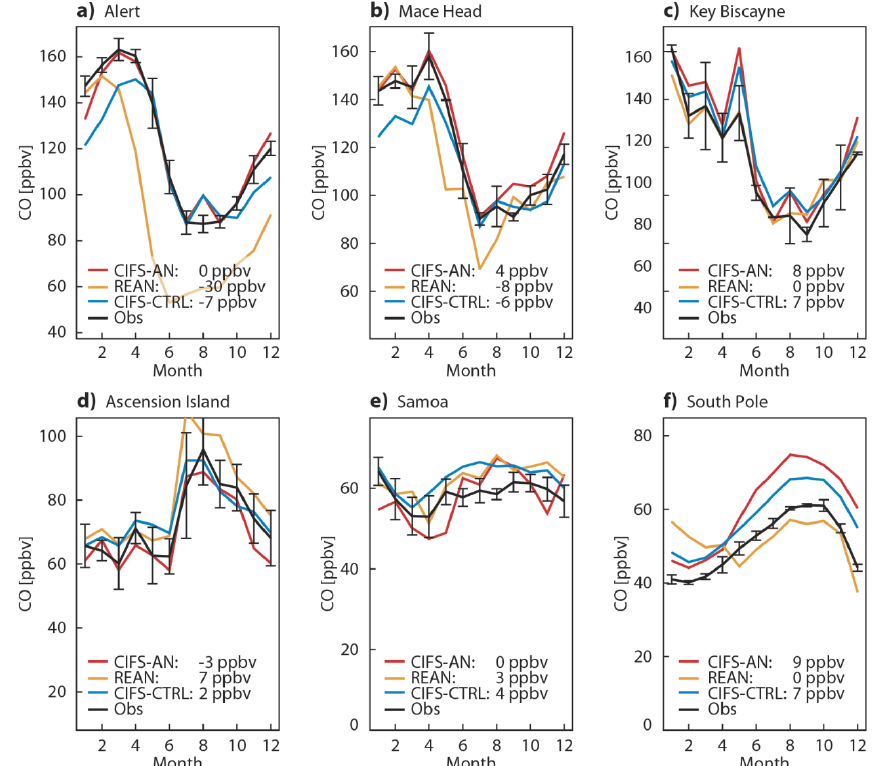
Figure 7. Time series for 2008 of monthly mean surface CO volume mixing ratios (ppbv) at a selection of GAW stations (black), CIFS-AN (red), CIFS-CTRL (blue) and REAN (orange): (a) Alert (82.3 ◦ N, 62.2 ◦ W), (b) Mace Head (53.2 ◦ N, 9.5 ◦ W), (c) Key Biscayne (25.4 ◦ N, 80.9 ◦ W), (d) Ascension Island (7.6 ◦ S, 14.3 ◦ W), (e) Samoa (13.5 ◦ S, 171.5 ◦ W) and (f) South Pole (90 ◦ S, 0 ◦ E). Error bars (only shown for the observations) denote the monthly mean variability in the observations. Also given is the annual mean bias of the three